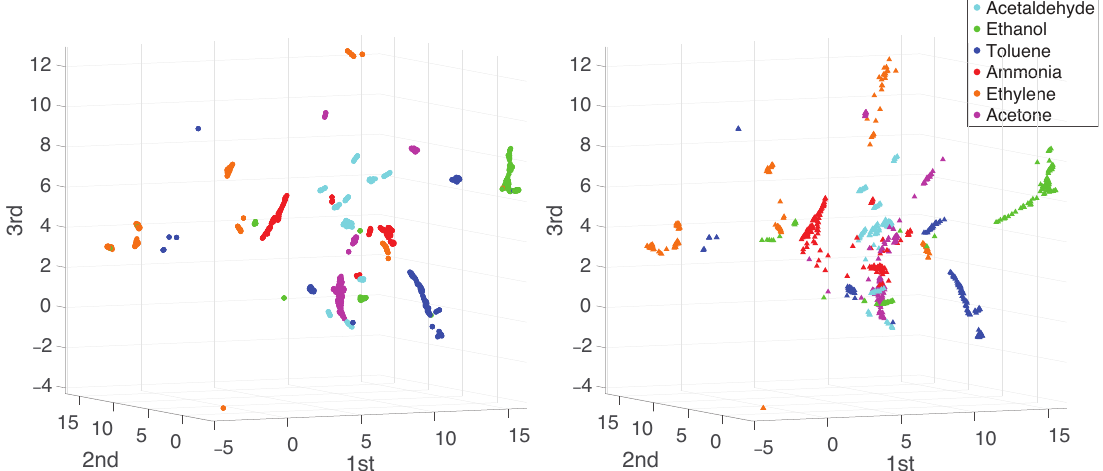
Figure 14. Scatter plot of the first three UMAP features of the data in dataset #1 (the training set is shown on the left and the test set is shown on the right ). The six different analytes are shown in different colors.